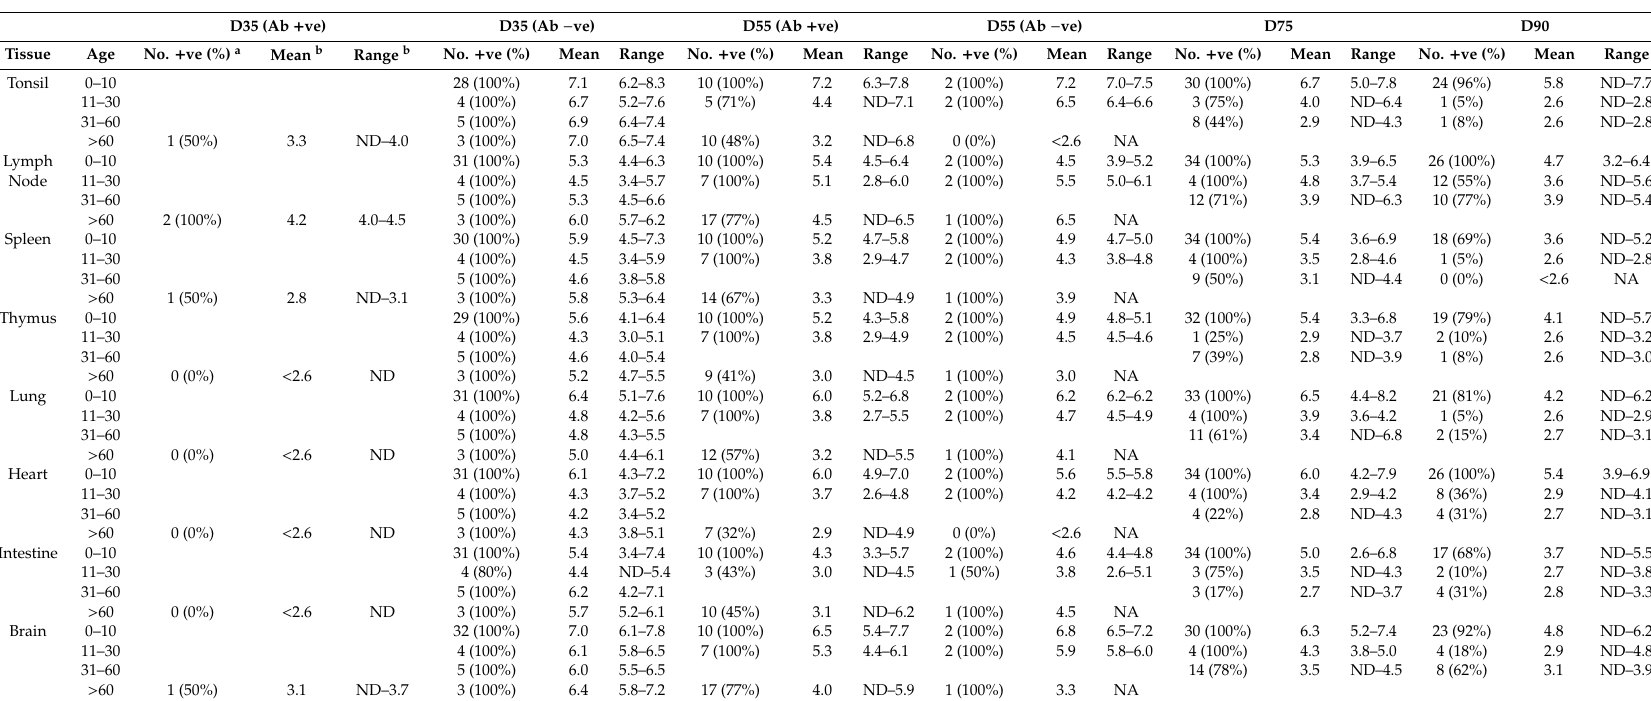
Table 1. Quantity of Bungowannah virus RNA detected in selected tissues at four time periods after birth in challenge groups D35, D55, D75 and